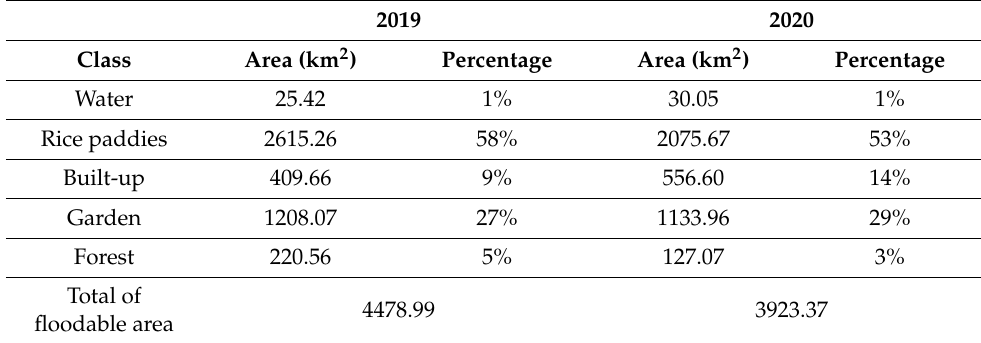
Table 9. Area estimation of land use/land class impacted by